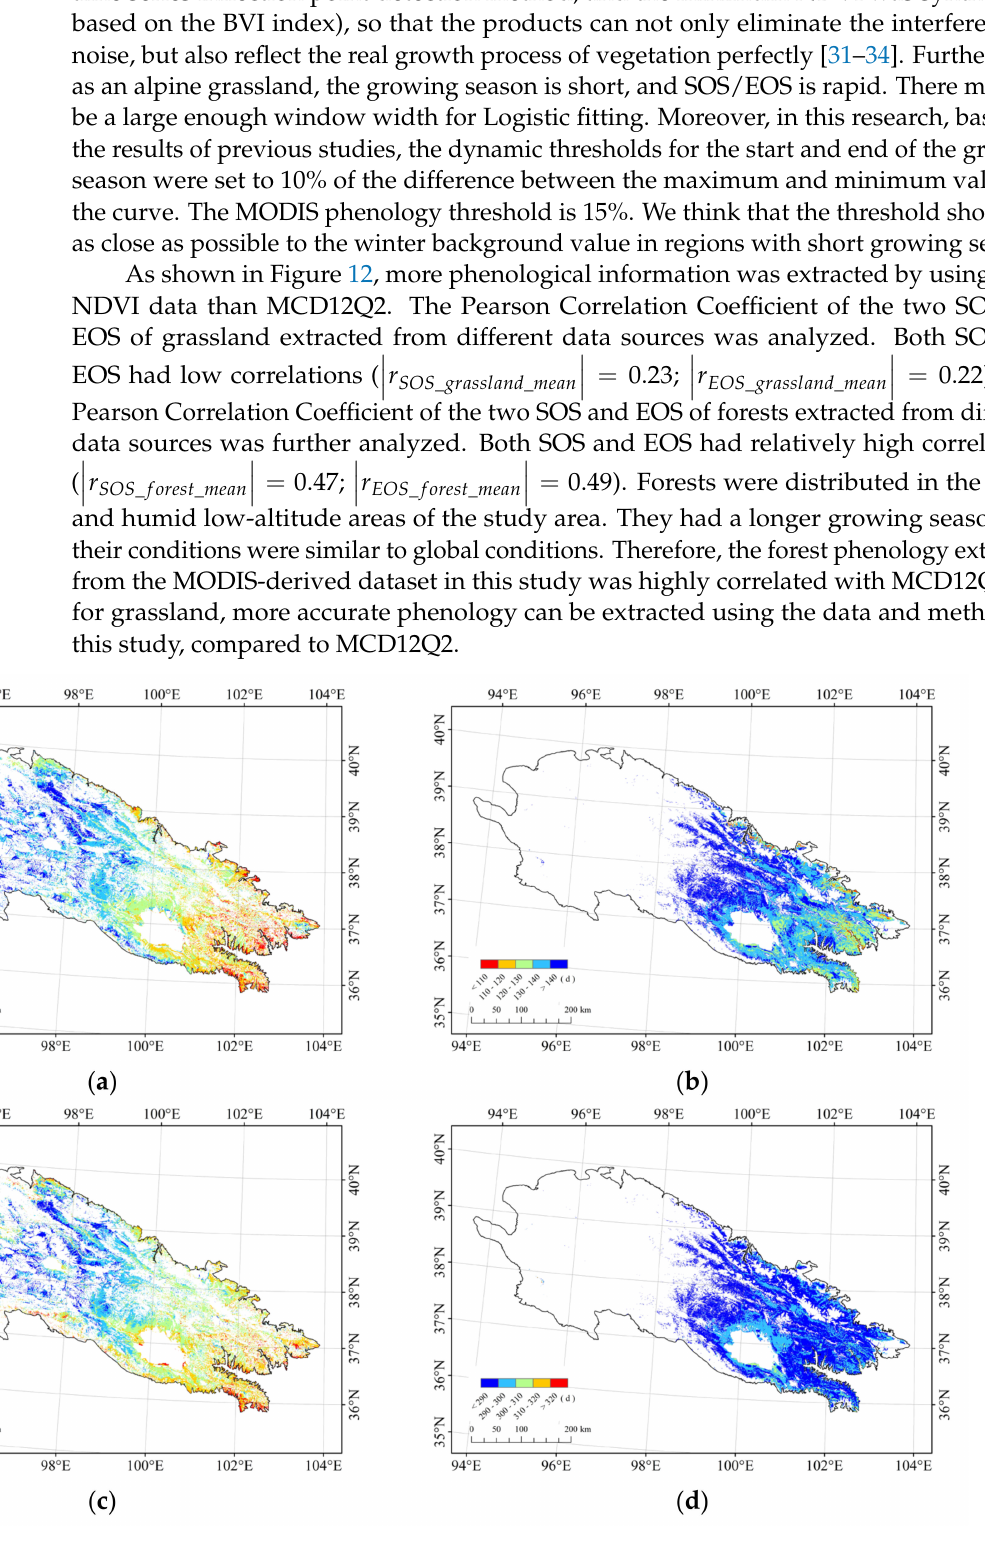
Figure 12. Comparison of phenology extracted from the MODIS-derived NDVI in this study and from the MCD12Q2. ( a ) SOS extracted from the MODIS-derived NDVI in this study; ( b ) SOS extracted from the MCD12Q2; ( c ) EOS extracted from the MODIS-derived NDVI in this study; ( d ) EOS extracted from the